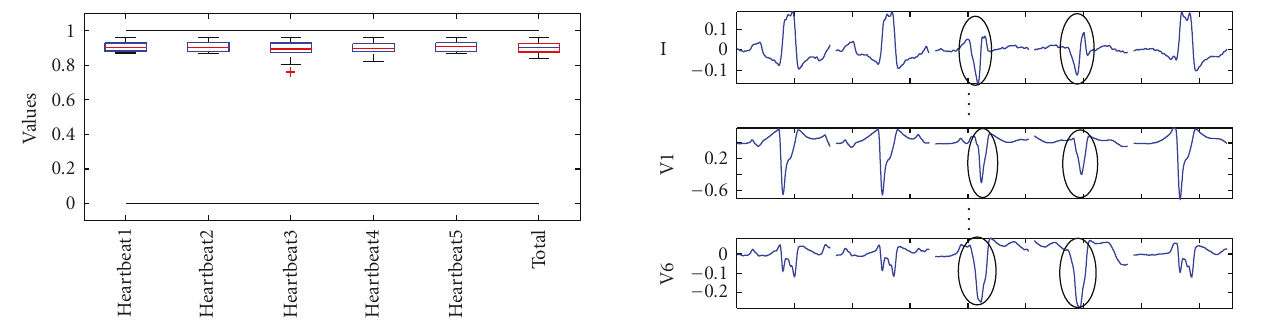
Figure 12: Example of a patient with cardiac arrhythmia: real ECG channels.